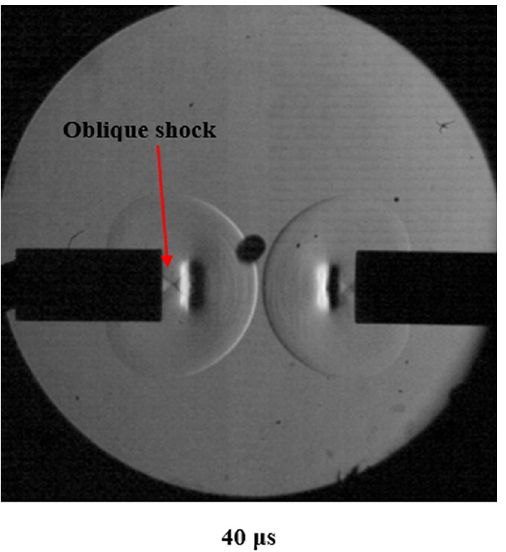
Figure 2. The oblique shock behind the vortex ring created by reflections of shocks in the tube.